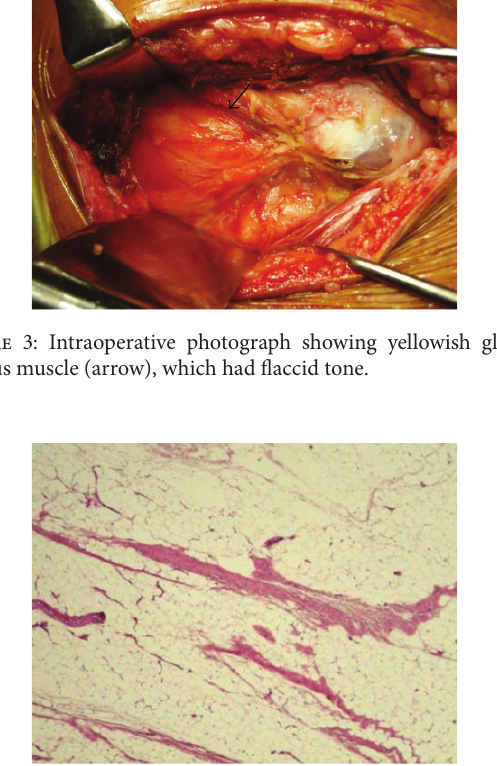
Figure 4: Histological examination of the gluteus medius muscle showing diffuse fat infiltration with a few atrophic muscle fibers, but no acute inflammation and no atypia (H and E, ×